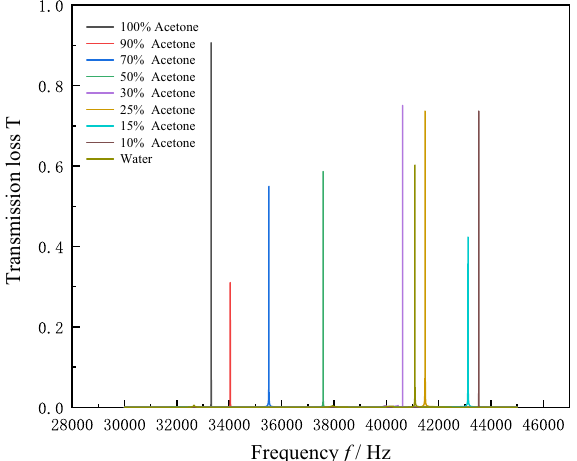
Figure 8. Acoustic transmission spectrum of 10–100% acetone solution sensed by PnC